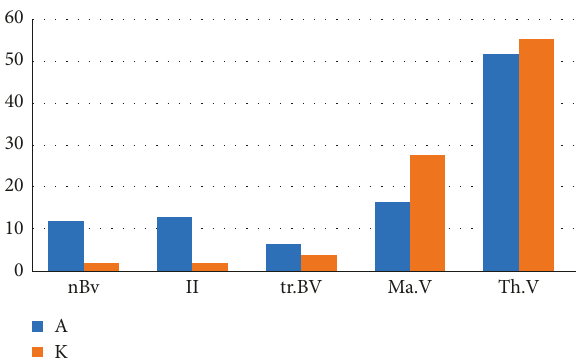
Figure 19: The distribution chart of the structural components of the cortical plate regenerated bone tissue 4 weeks after the for- mation of a bone defect and introduction of a suspension of calcium hydroxide with and without nanodispersed cerium di- oxide. nBv is the relative volume of the newly formed bone tis- sue(%), II is the relative volume of the granulation tissue (%), and MatV is the relative volume of the material (%) (A—with cerium dioxide and K—without cerium dioxide).